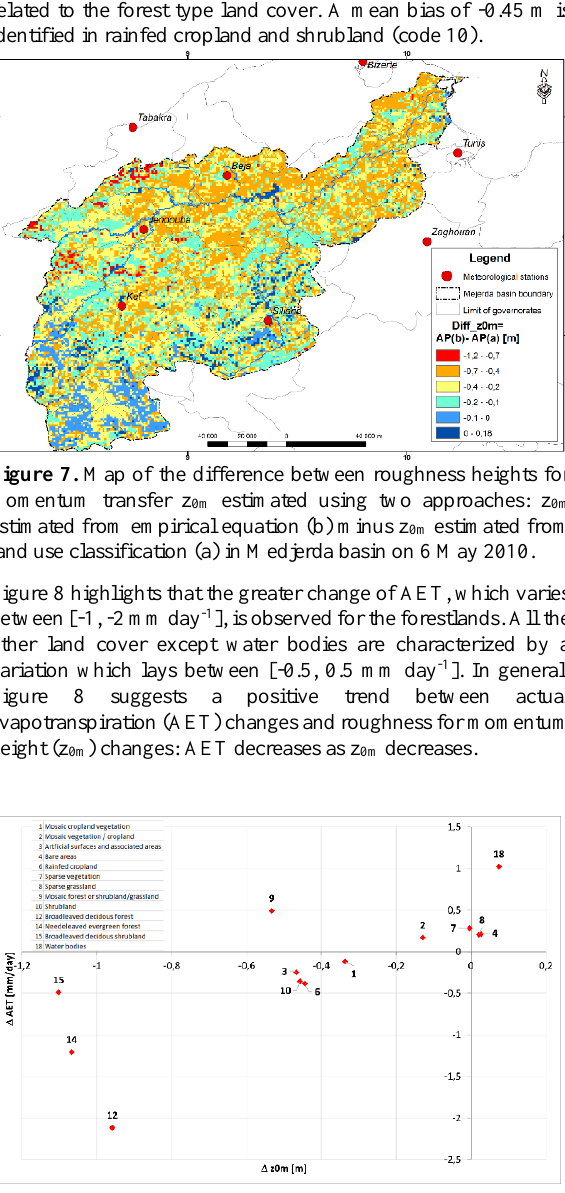
Figure 8. Scatter plot of AET change against roughness height for momentum transfer change by land cover types due to shifting from z 0m derived from PELCOM to empirical z 0m using Spot NDVI map for May 6, 2010 in Medjerda